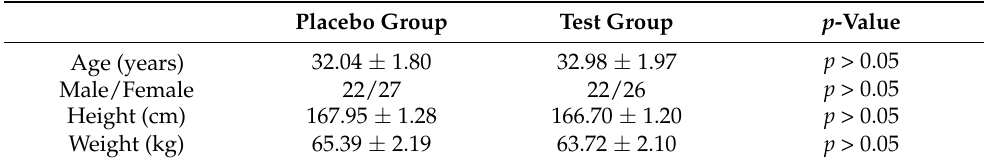
Table 1. Demographic table at baseline (mean ± SD).